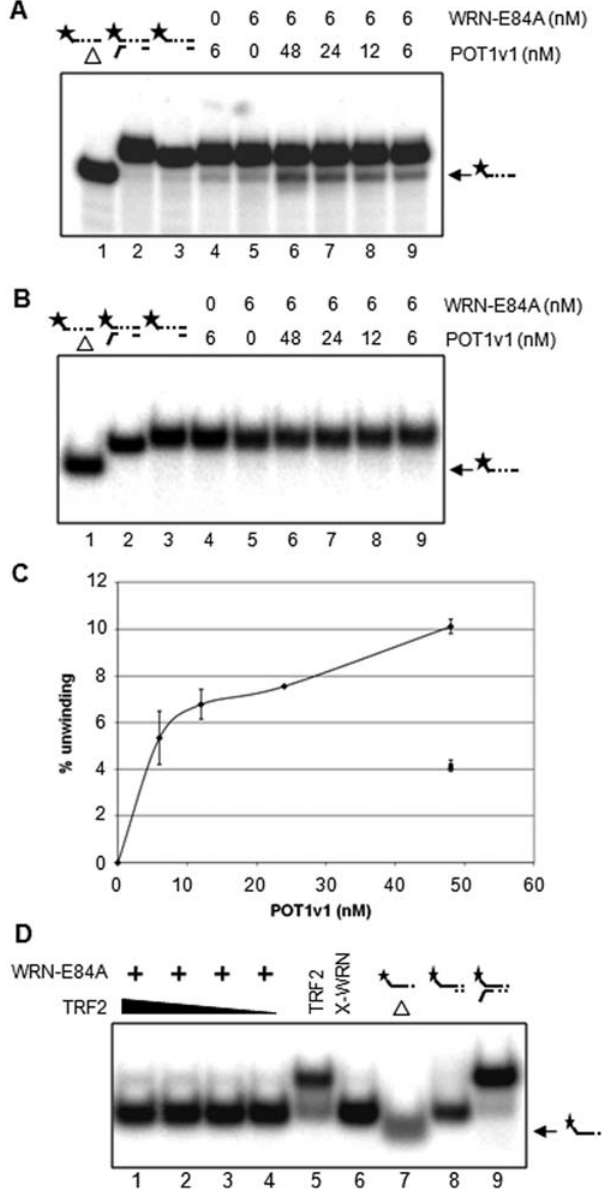
Figure 6. Radiometric DNA helicase assay using WRN in the presence of POT1. The concentration range of POT1 variants used in these reactions was from 6 to 48 nM. The concentration of WRN-E84A was held constant at 6 nM. The DNA substrate used for these reactions is shown in Figure 1B[d]. (A) The reaction mixtures contained POT1v1 and WRN-E84A with the DNA substrate for POT1v1 to pre-bind. (B) The reaction mixtures contained POT1v2 and WRN-E84A with the same DNA substrate as (A). (C) Quantitations of at least two or more independent experiments shown in (A) is plotted. The graph is plotted as the percent of displacement of the radiolabeled oligomer on the Y-axis and the concentration of POT1 variants on the X-axis. Filled diamond represents reaction mixtures containing POT1v1 and WRN-E84A. Filled circle represents reaction mixture containing only POT1v1 and Filled triangle only WRN-E84A. (D) The reaction mixtures contained TRF2 and WRN- E84A with DNA substrate for TRF2 to pre-bind as shown in 1B[c]. TRF2 was added in these reactions from 12 nM (lane 4), 25 nM (lane 3), 50 nM (lane 2) to 100 nM (lane 1) and the concentration of WRN-E84A was held constant at 6 nM. Asterisk indicates a 5 9 - 32 P labeled strand. D indicates boiled substrate.